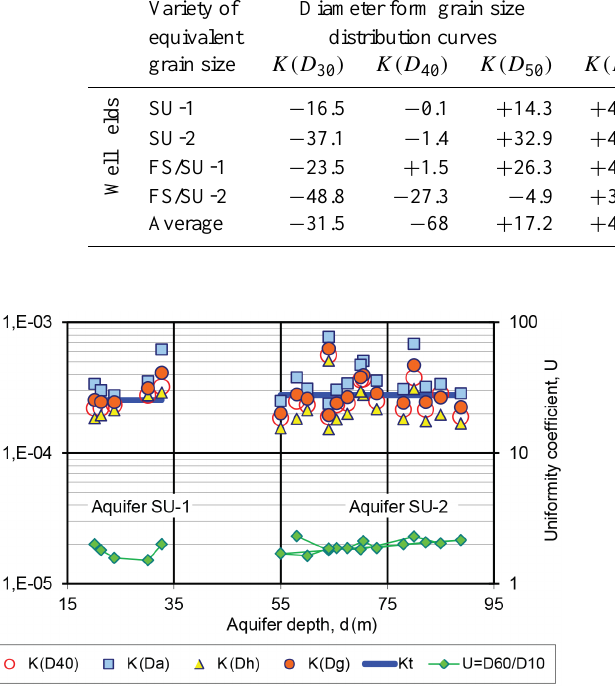
Table 1. Average difference (%) between predicted and tested hydraulic conductivity for sandy aquifers. Variety of Diameter form grain size Mean grain size Tested K t